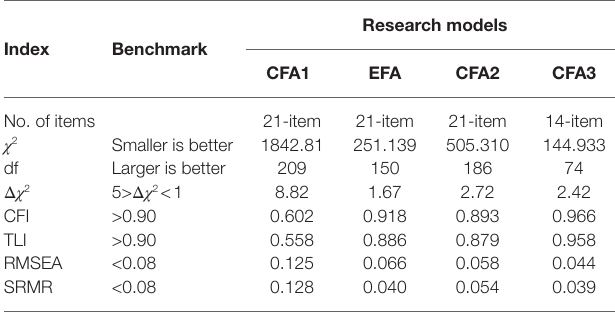
TABLE 2 | CFA and EFA results of the 21-item and 14-item versions of foreign language flow